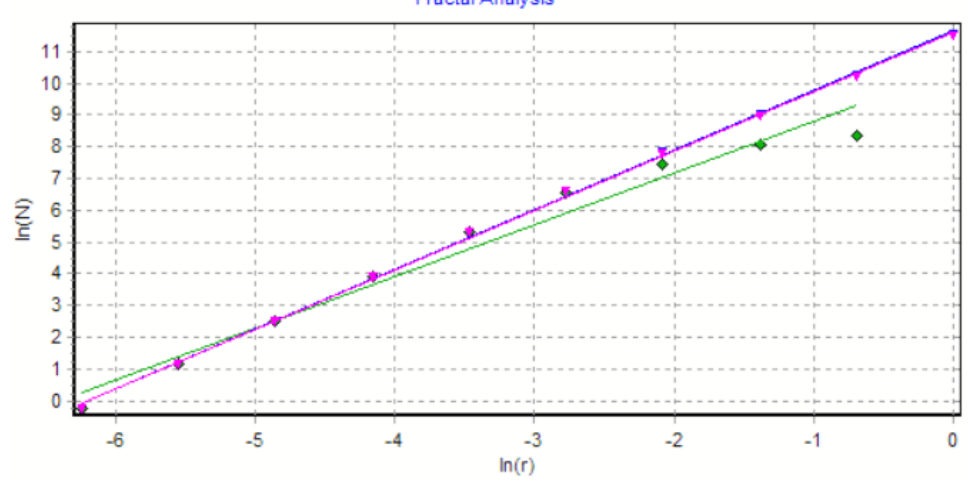
Figure 13. Graphic of fractal dimension for selected U 2 image area. Figure 14 represents the three-dimensional graph of voxel representation for the im- age U 2 from the modified area.